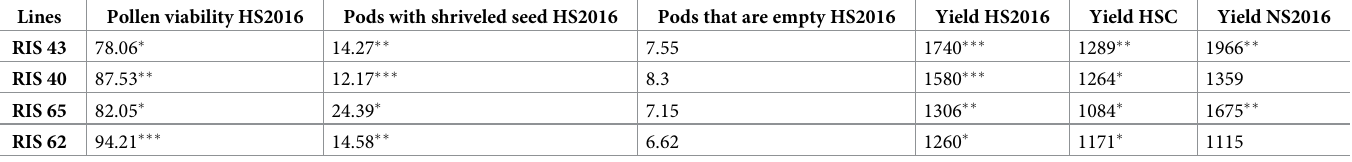
Asterisks indicate if the lines belong to the best 50% ( � ), best 25% ( �� ) or best 10% ( ��� ) of the respective data